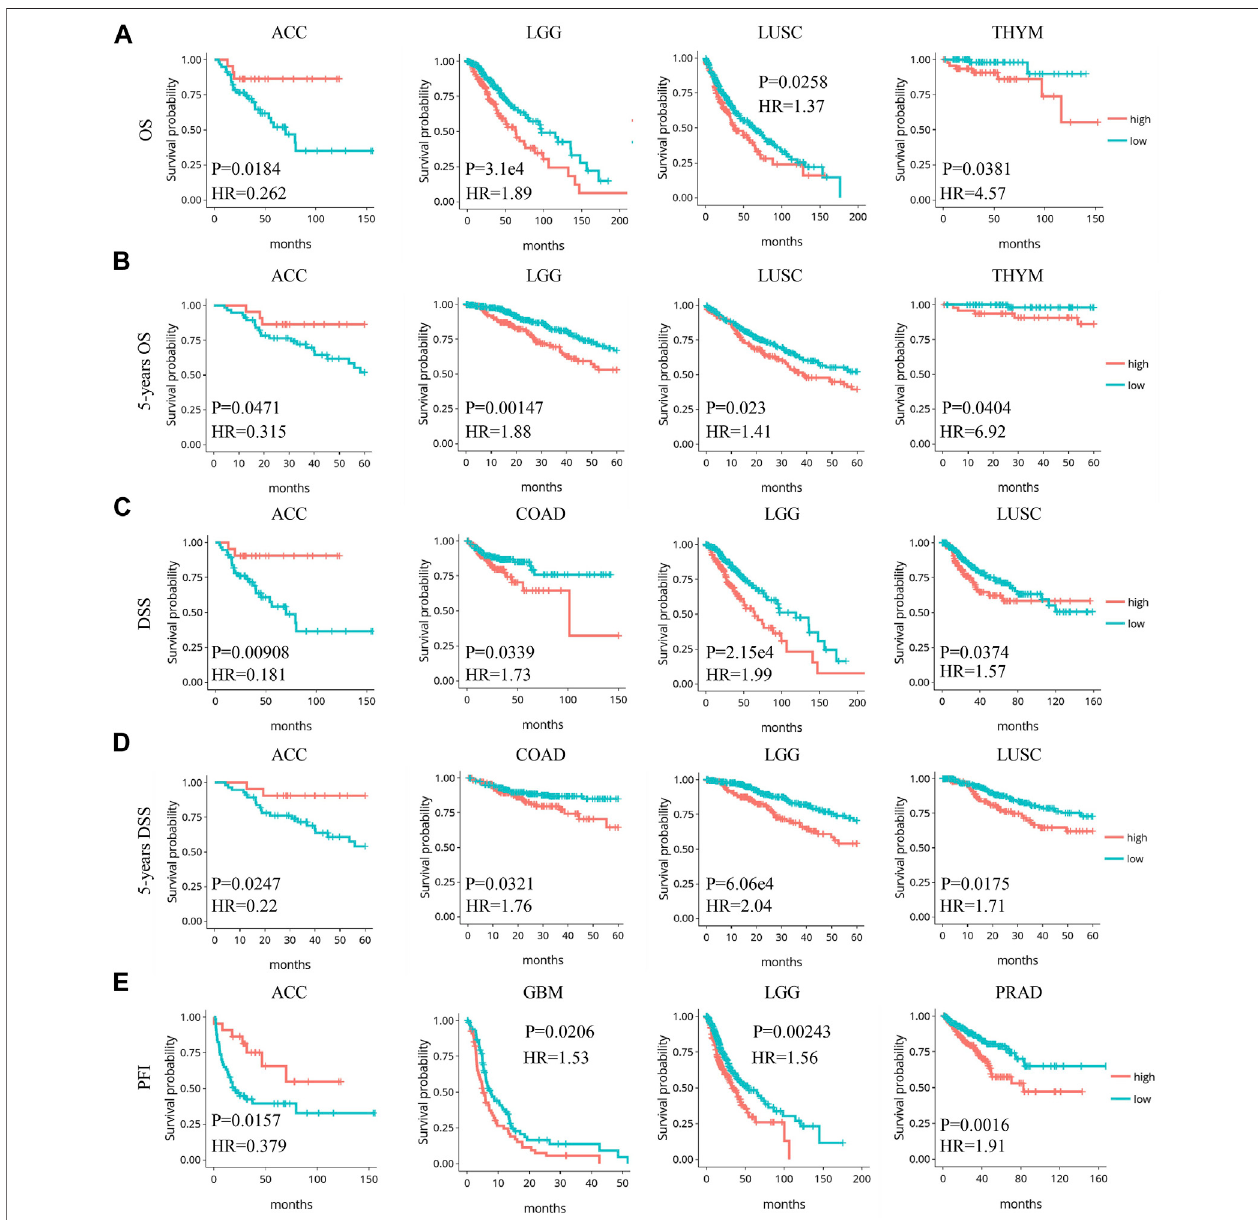
FIGURE 3 | Signi fi cant correlation between Siglec-9 expression and prognostic value in pan-cancer relied on DriverDBv3. (A) Expression of Siglec-9 was associated with overall survival (OS) in LGG, ACC, LUSC, and THYM. (B) Expression of Siglec-9 was associated with 5-year OS in LGG, ACC, LUSC, and THYM. (C) Expression of Siglec-9 was associated with disease-speci fi c survival (DSS) in ACC, COAD, LGG, LUSC. (D) Expression of Siglec-9 was associated with 5-year DSS in ACC, COAD, LGG, and LUSC. (E) Expression of Siglec-9 was associated with progression-free interval (PFI) in ACC, GBM, LGG, and PRAD ( p < 0.05 was considered signi fi cant. HR: hazard